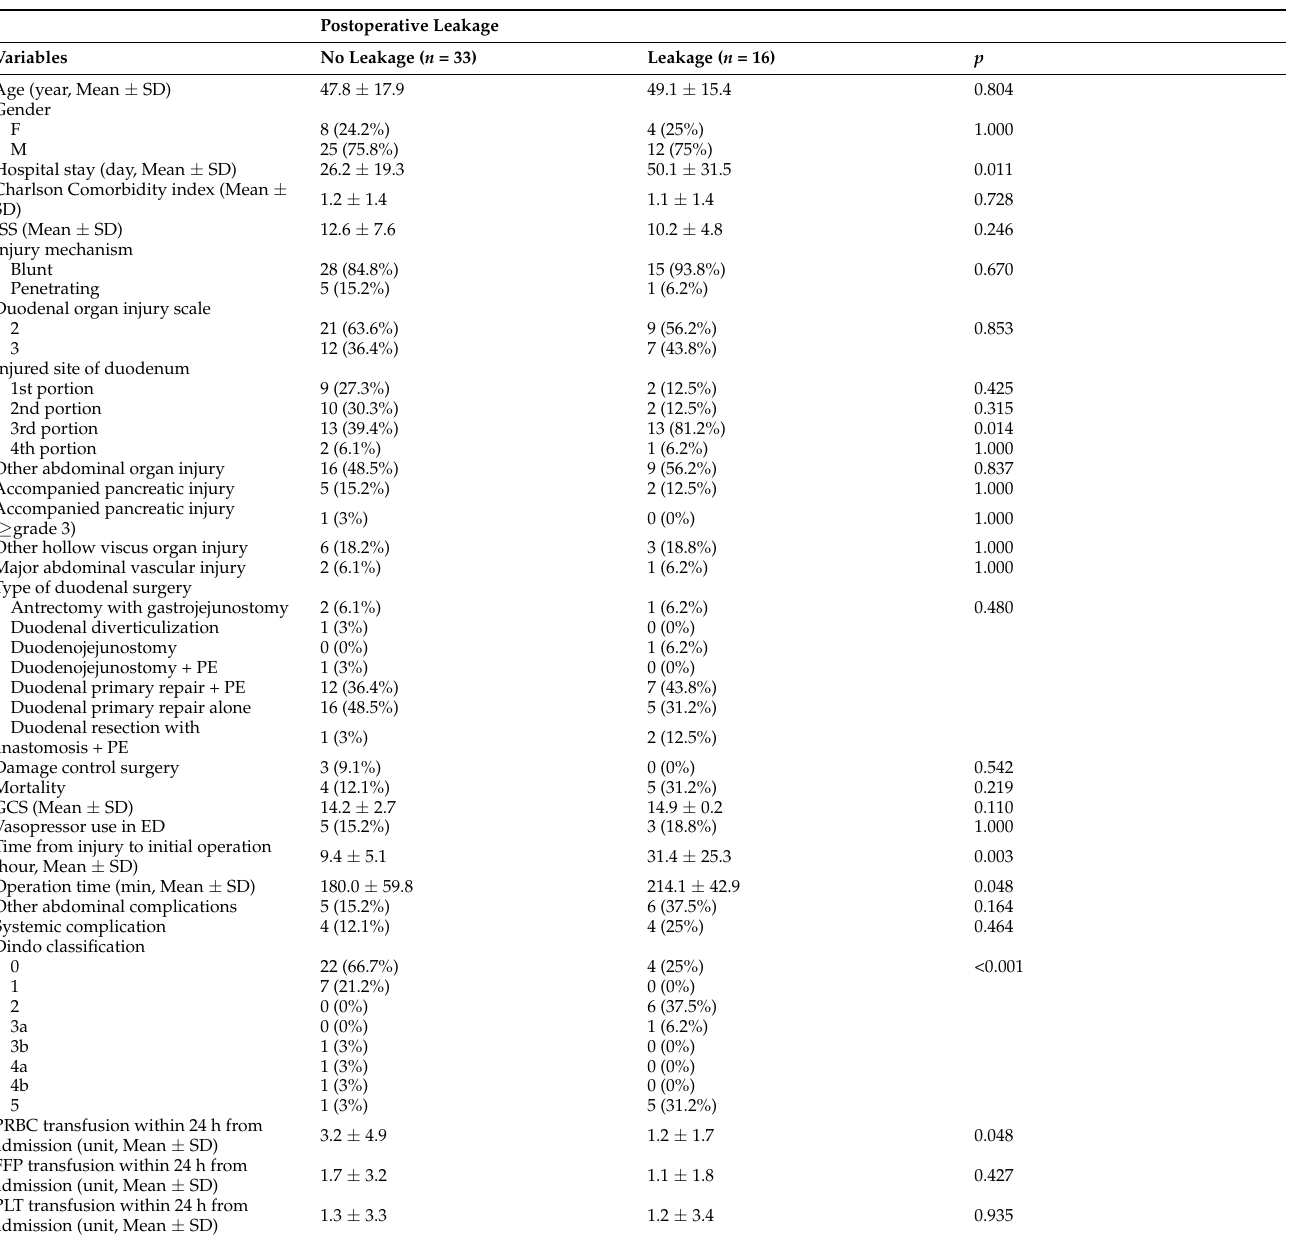
Table 1. Difference in clinical characteristics of patients with postoperative leakage and with no